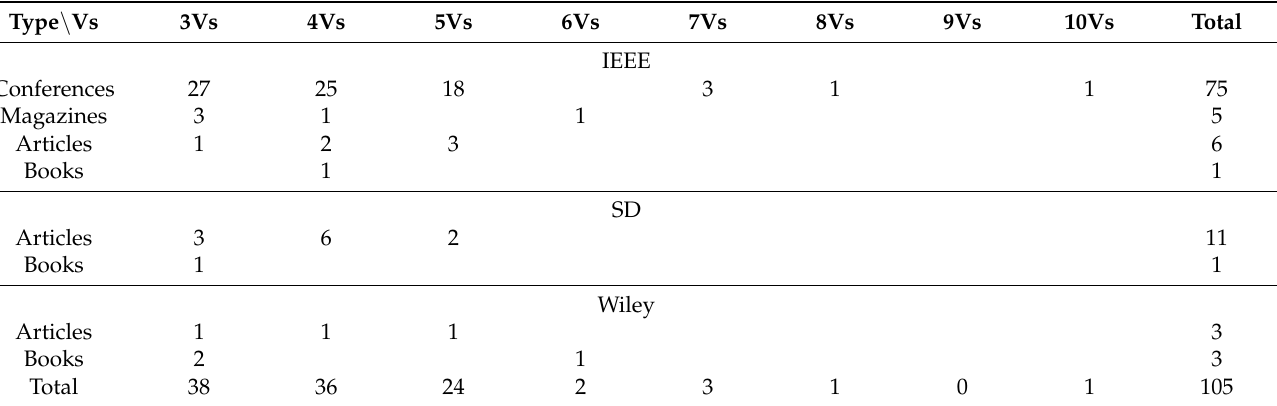
Table 3. Type of article in each database according to the Vs they